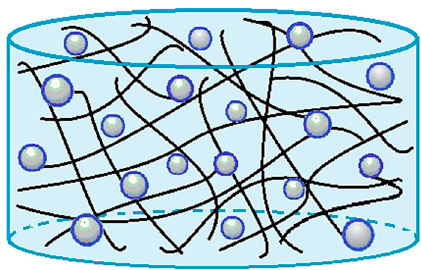
Figure 3. A sketch of PVP-based hydrogels.